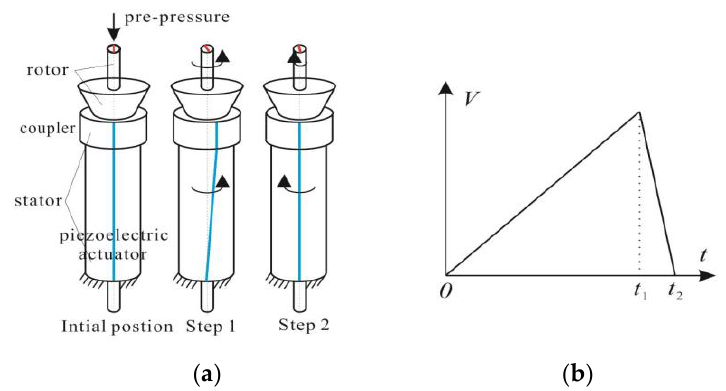
Figure 1. Working process of an impact rotary motor: ( a ) Working principle; ( b ) Driving signal.